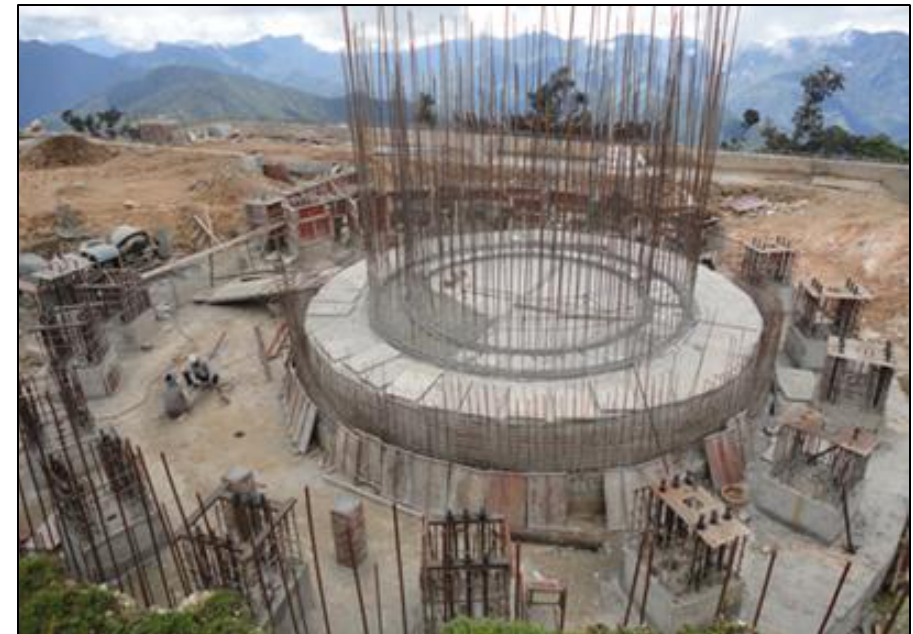
Figure 4. Construction of building and pier in